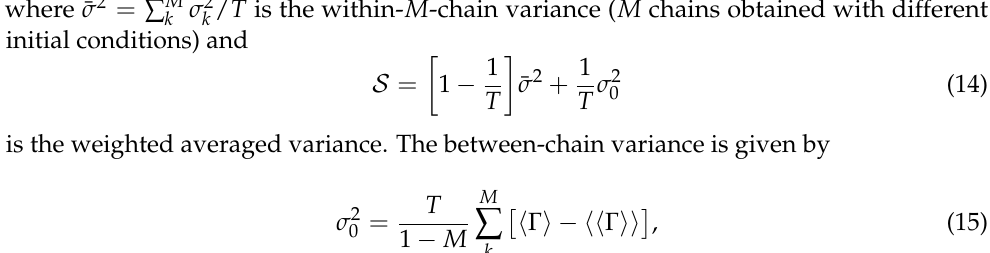
Figure 2. MCMC chain ( a , d ) and respective posterior distributions ( b , e ) for both Γ 1 (upper panels) and Γ 2 (lower panels) obtained with ρ 1 = ρ 0 and ρ 2 = 2 ρ 0 with T = 5 of the posterior average values along the chain is small σ P ( Γ ) / T portion of the posterior distribution is due to sampling error. This can be visualized in the moving average of the MCMC chains. Autocorrelation functions are shown in ( c , f